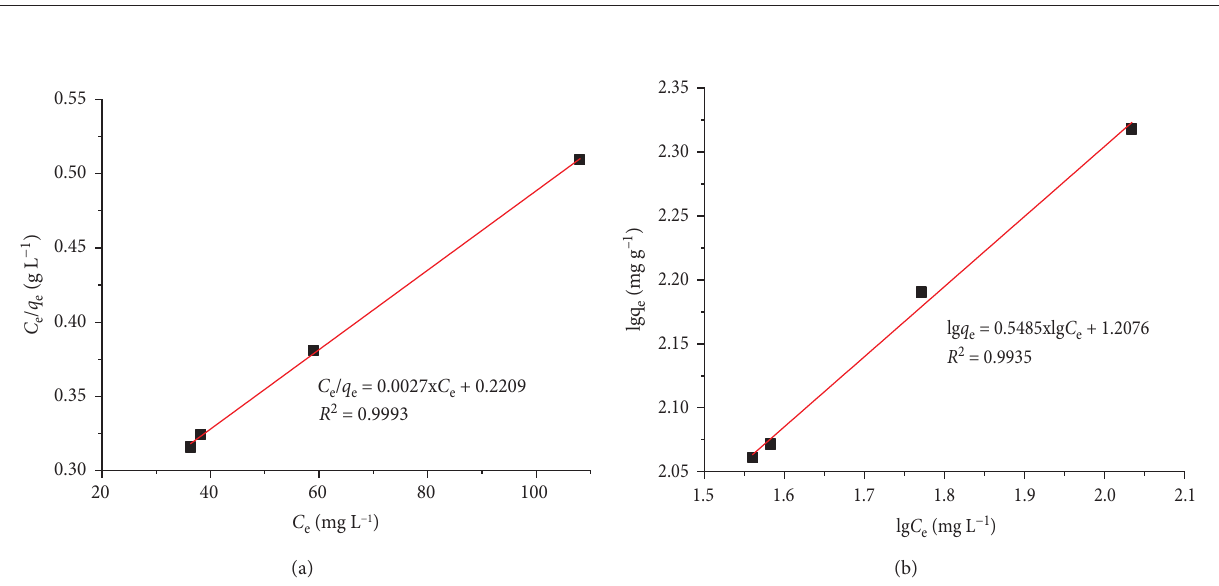
Figure 4: Adsorption isotherm following (a) Langmuir and (b) Freundlich models for Co 2+ ion adsorption onto the GO/PVA/Fe